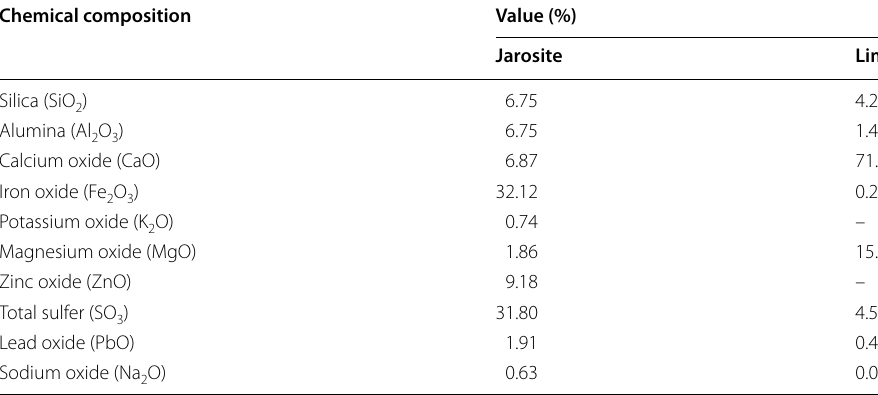
Table 2 Chemical composition of